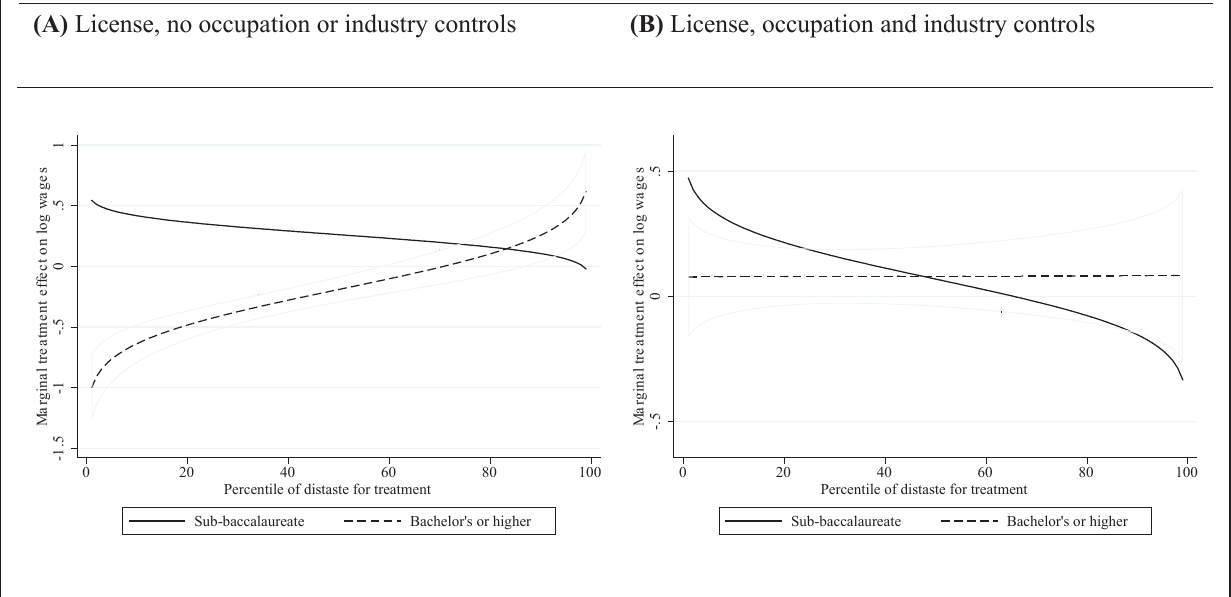
Figure 3 MTEs of occupational credential-holding for log wages, conditional on being employed. (A) License, no occupation or industry controls (B) License, occupation and industry controls